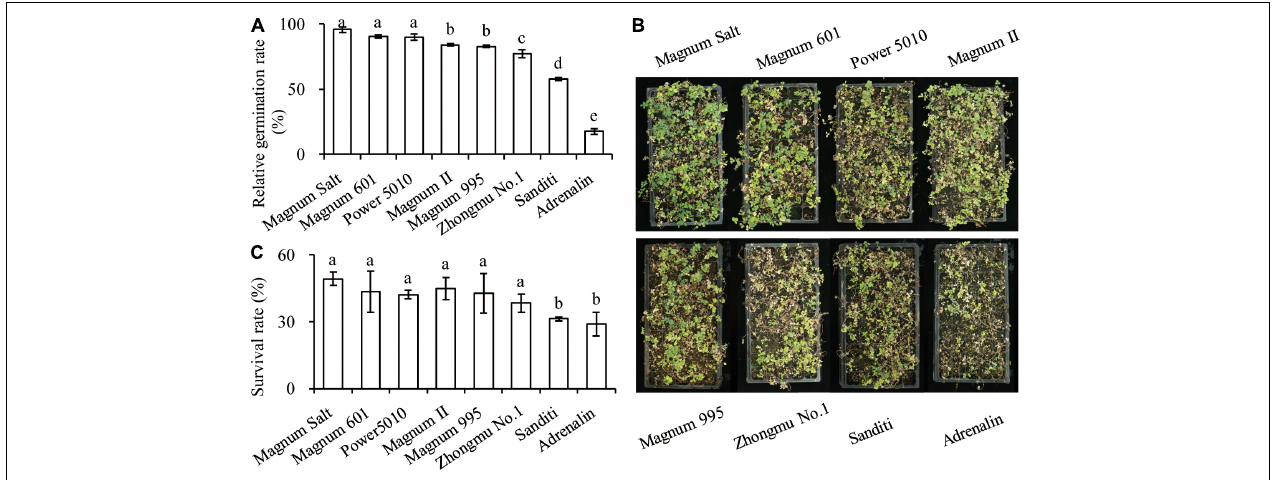
FIGURE 1 | Evaluation of salt tolerance of 8 alfalfa cultivars by analyzing relative germination rate and survival rate under salt condition. Alfalfa seeds were treated with 0 or 150 mM NaCl solution, and relative germination rate (A) were calculated within 7 days. Four-week old seedlings treated with Hoagland nutrient solution with 500 mM NaCl (pH 5.8) weekly. Three weeks later, photographs (B) were taken and survival rates (C) were analyzed. Values are mean ± SE ( n = 3 replicates). Different letters ( P < 0.05, one-way ANOVA) compare different